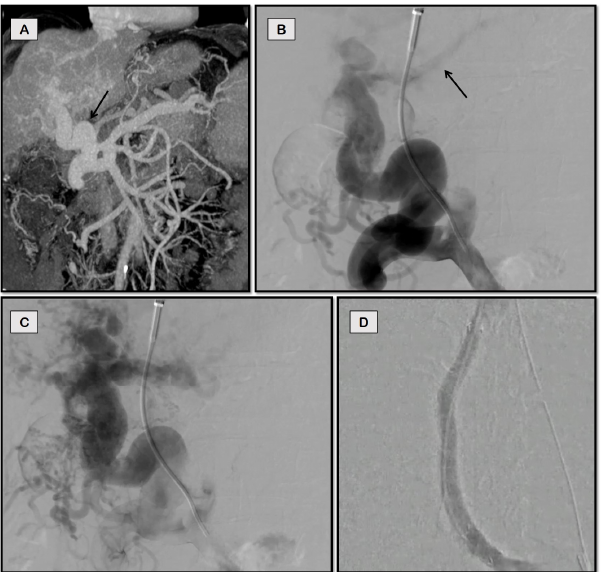
Figure 3. TIPS for refractory ascites in a 53-year-old man with cirrhosis and chronic portal vein thrombosis due to non-alcoholic steatohepatitis (NASH). Coronal-oblique CT image ( A ) shows a large periportal collateral (arrow) replacing the native main portal vein. The main portal vein was accessed through middle hepatic vein via partially patent left portal vein (faintly opacified on B , arrow) from the jugular approach. Image ( C ) shows the portal cavernoma. Optimal flow of contrast was noted post-stenting ( D ) with disappearance of collaterals. Initial attempts at TIPS in patients with portal vein thrombosis utilized the transhepatic approach [14]. Briefly, a micropuncture set is used to access the thrombosed portal vein under fluoroscopic or ultrasound guidance. After balloon dilatation and thrombus aspiration from the portal vein, an inflated contrast-filled balloon or vascular snare is placed, which can be used as a target to puncture the portal vein from the transjug- ular approach. The rest of the procedure is completed from the jugular side in the standard fashion. The transhepatic tract is plugged with gel foam, coils, or glue. In patients with concomitant chronic thrombosis of hepatic veins (chronic Budd–Chiari Syndrome), this approach can be modified by simultaneously puncturing the thrombosed portal vein and the inferior vena cava (IVC) and snaring the guidewire from IVC through the jugular route (Figure 4).